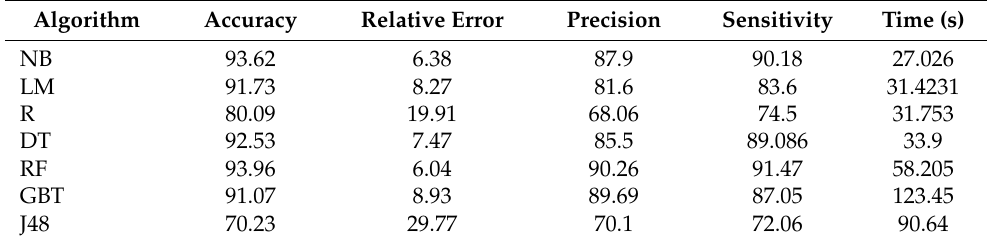
Table 8. Comparison between different algorithms applied on diabetes data without preprocessing.